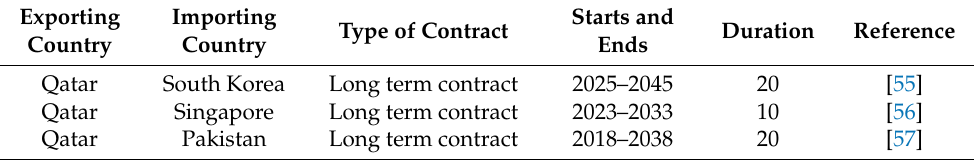
Table 1. Some examples of recent long-term contracts between Qatar and other countries.